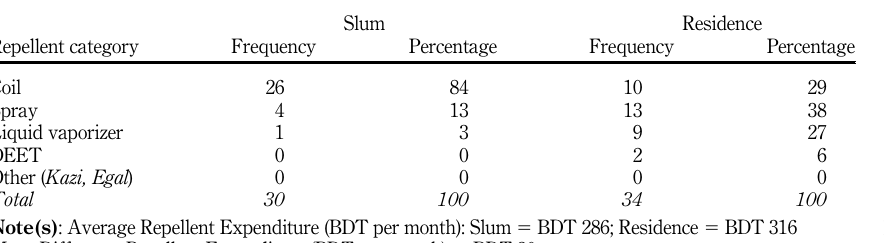
Table 2. Preferred category